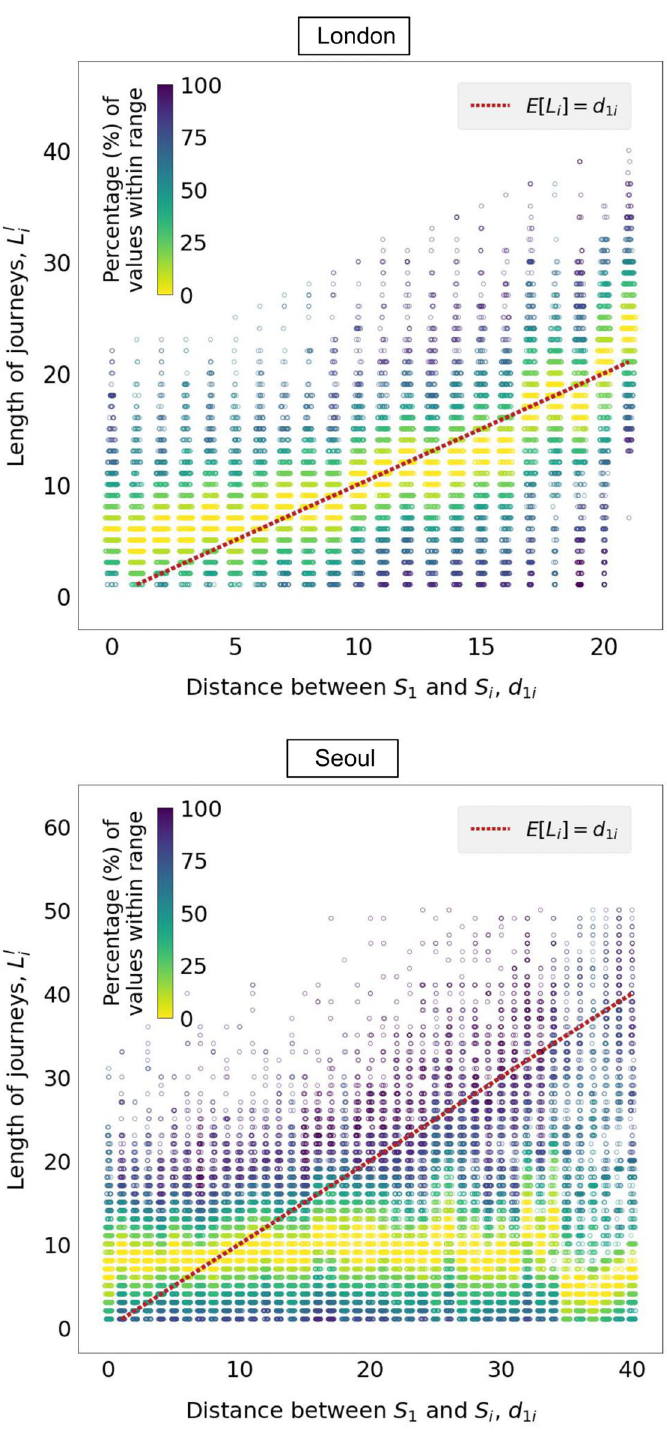
Figure 3. Distribution of the length of journeys terminating at any destination station which is at a given distance from the nucleus. The solid line indicates the median of the distribution for each value of d 1 i . The dashed line represents the line L l i = d 1 i